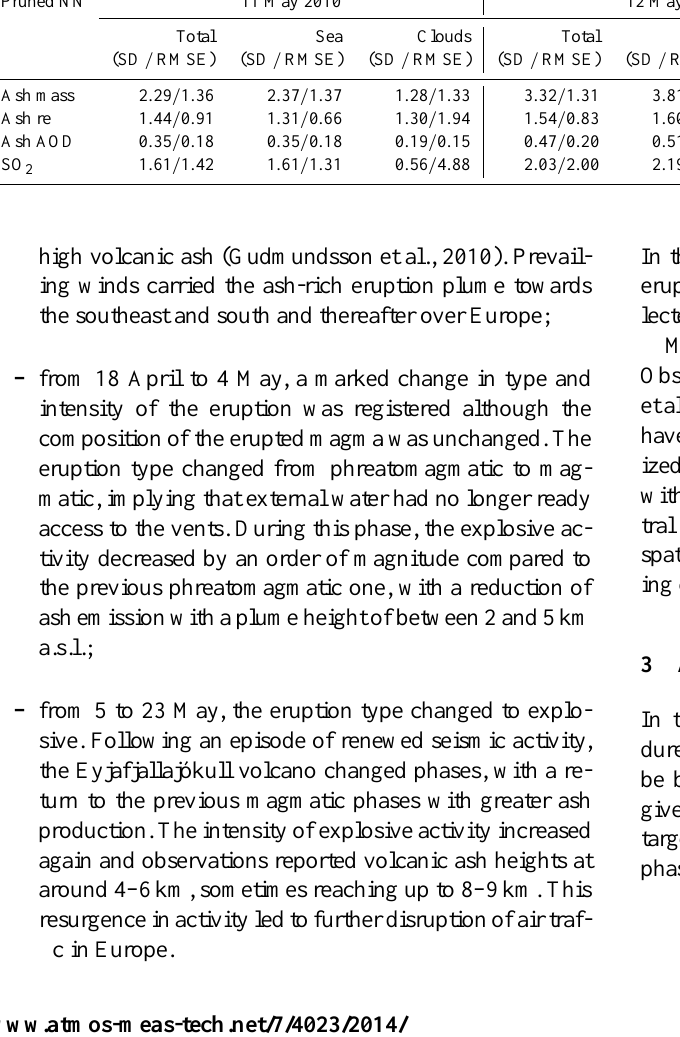
Table 8. RMSE values related to ash parameters and SO 2 for the independent validation sets. Pruned